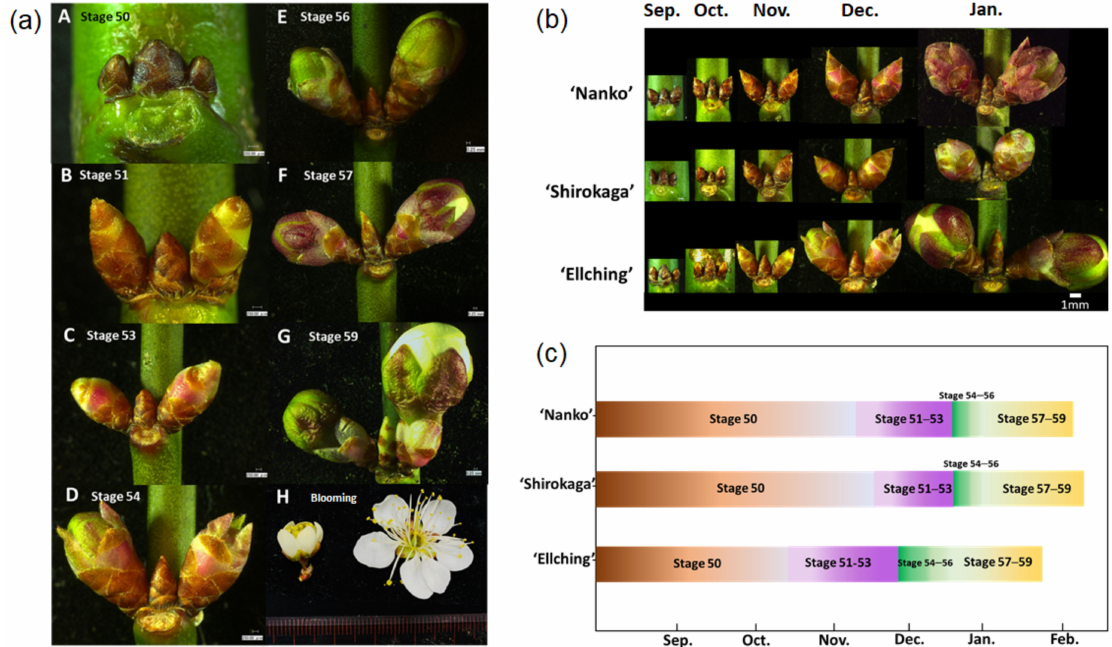
Figure 6. Evaluation of three Japanese apricot cultivars during dormancy using the modified BBCH scale. ( a ) Floral bud developmental stage. Scale bar = 250 µ m. ( b ) Seasonal changes in the bud appearance among Japanese apricot cultivars with varying blooming dates. Scale bar = 1 mm. ( c ) BBCH scheme of three Japanese apricot cultivars during dormancy. ‘Nanko’, high chill; ‘Shirokaga’, extra high chill; ‘Ellching’, low chill.